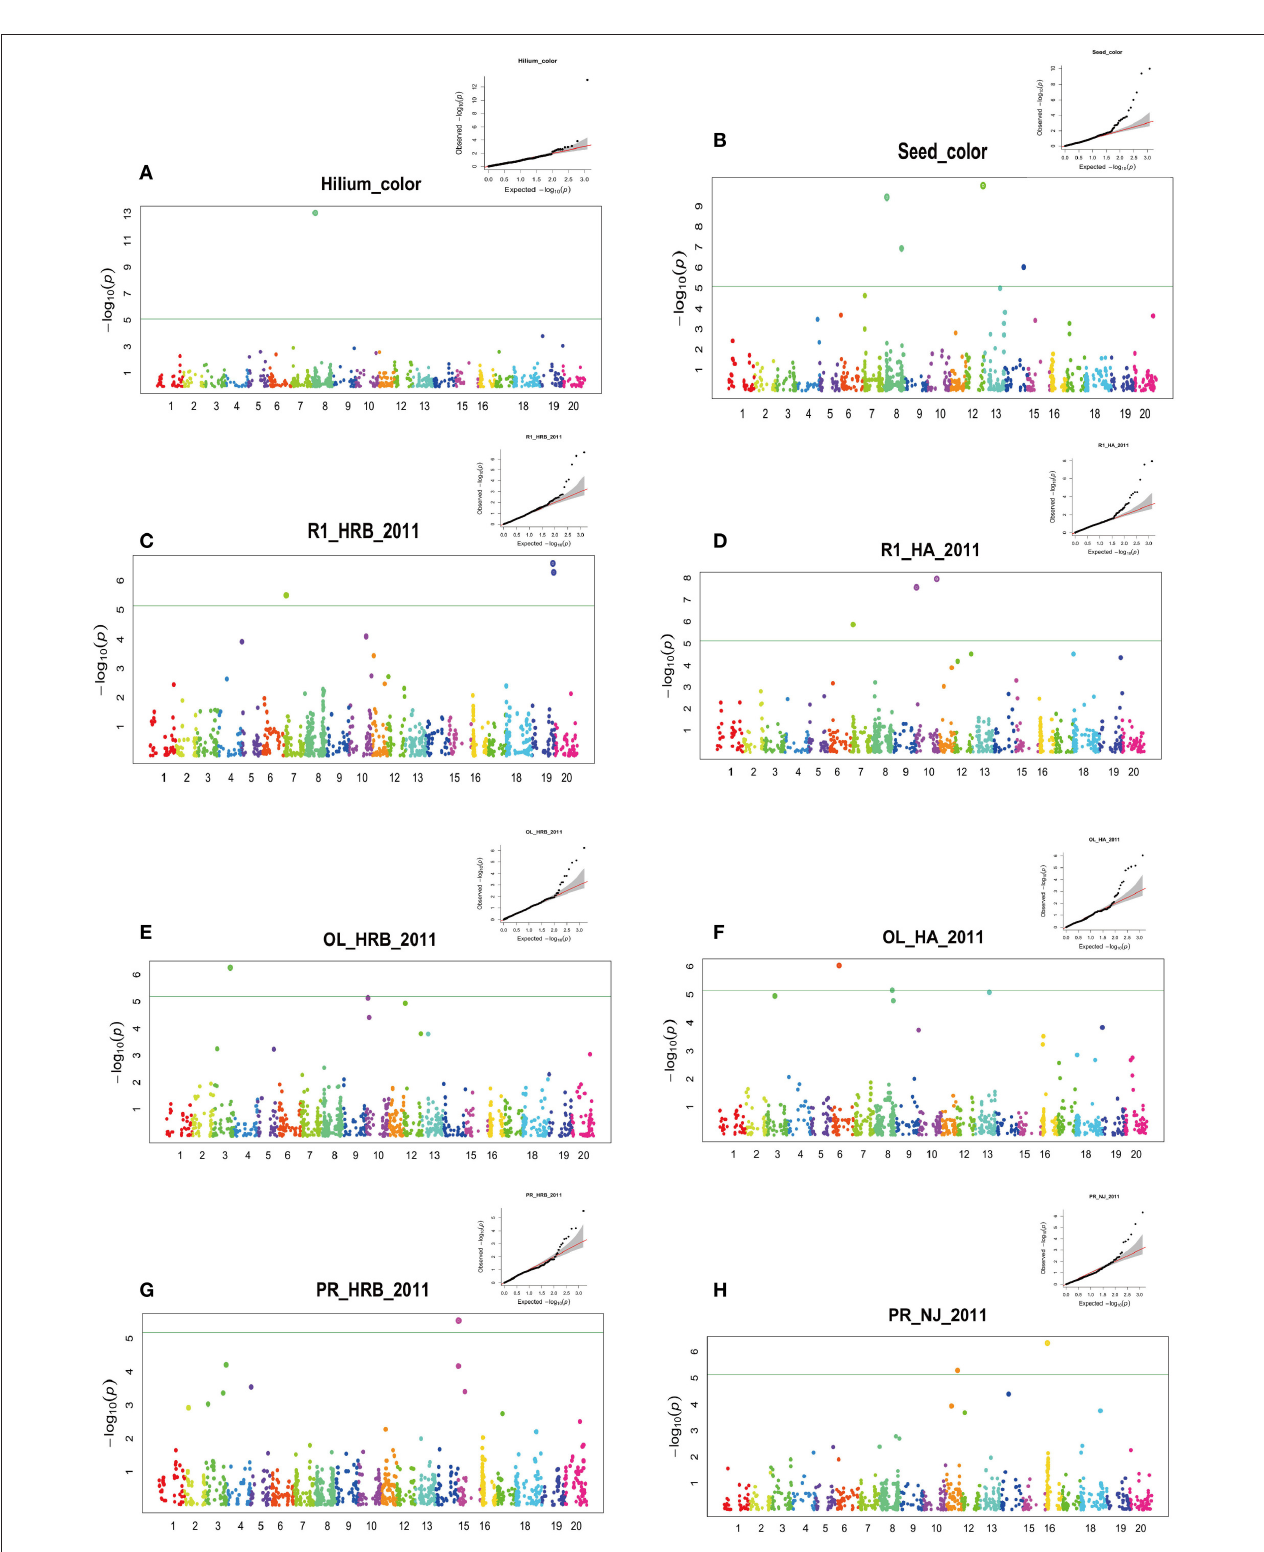
FIGURE 3 | GWAS of seed hilum color, seed coat color, flowering time (R1), protein and oil using FarmCPU. Manhattan plots (bottom) and Quantile-quantile (upper right) plot. Negative log10 P -values from a genome-wide scan are plotted against SNP positions of 20 chromosomes. The horizontal dash line indicates the significant threshold (2 × 10 − 5 ). (A) Hilium color at Harbin in 2011; (B) Seed coat color at Harbin in 2011; (C) Flowering time (R1) at Harbin in 2011; (D) Flowering time (R1) at Huaian in 2011; (E) Oil content at Harbin in 2011; (F) Oil content at Huaian in 2011 (G) Protein content at Harbin in 2011 (H) Protein content at Nanjing in 2011.